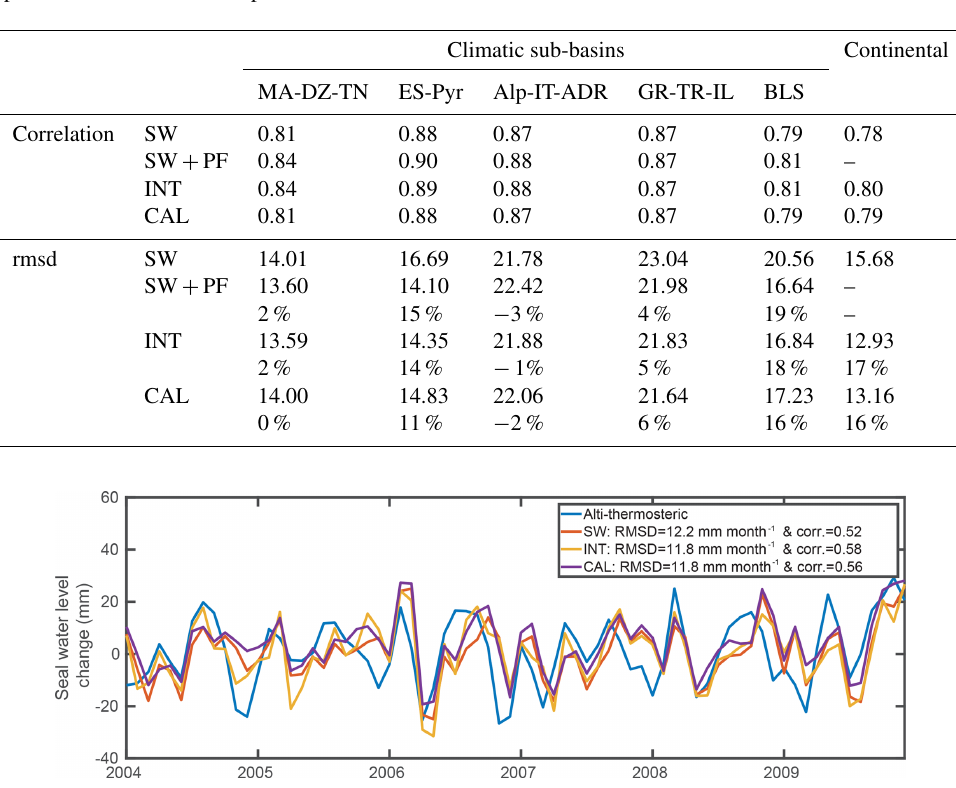
Table 5. Comparison of the SW, SW + PF, INT and CAL precipitation solutions with the EOBS dataset, in terms of correlations, rmsd, and percentage of improvement of the rmsd compared to the SW solution.